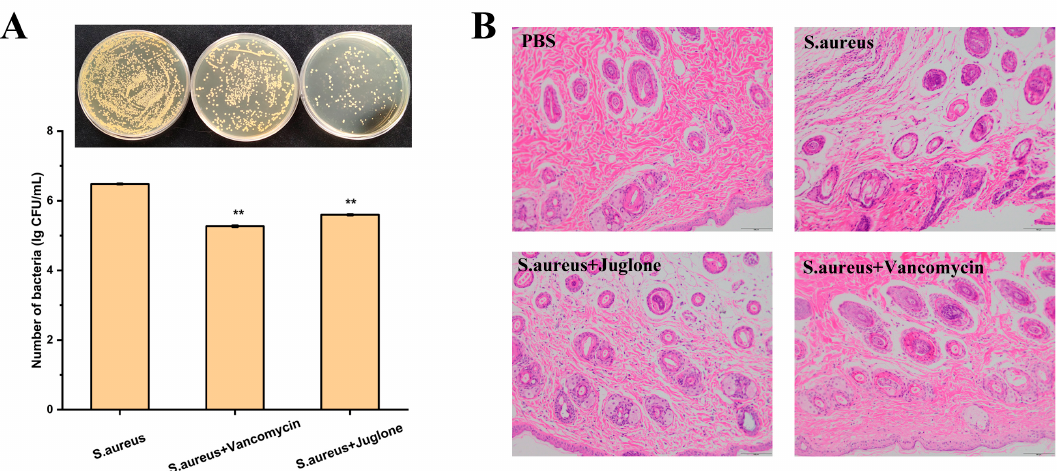
Figure 9. Effect of juglone topical treatment on wound bacterial load and wound histological anal- ysis. ( A ) Bacterial load of wounds after 2 d of treatment in different treatment groups. ( B ) Histolog- ical evaluation of different treatment groups after 14 d of treatment. Wound tissue uninoculated